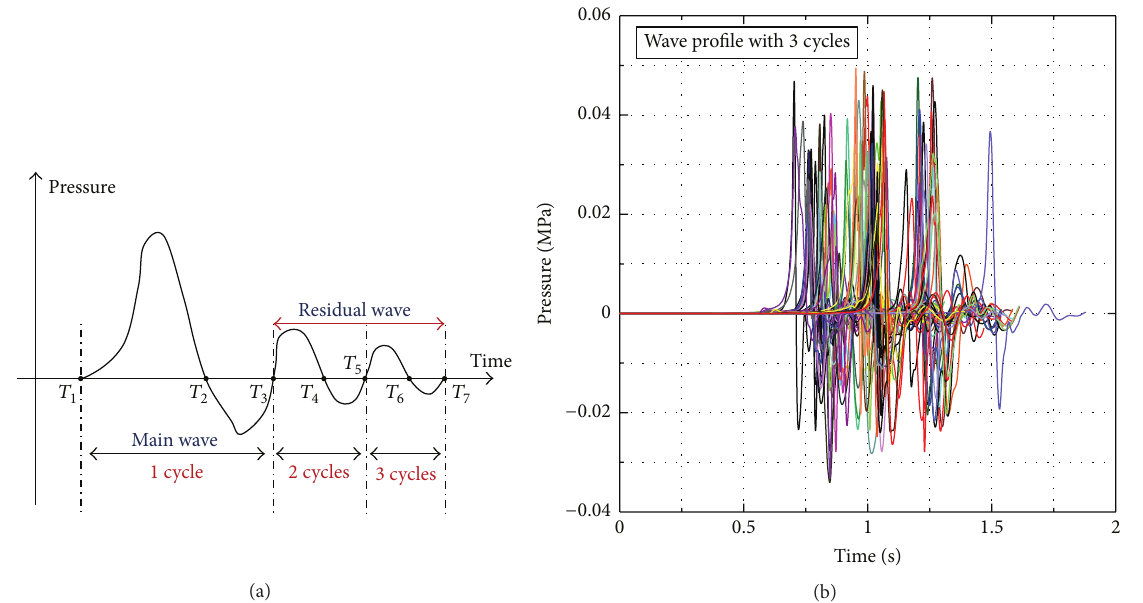
Figure 11: Residual waves effect analysis. (a) The standard for the cyclic wave profiles. (b) Extraction of target data by VBA code.